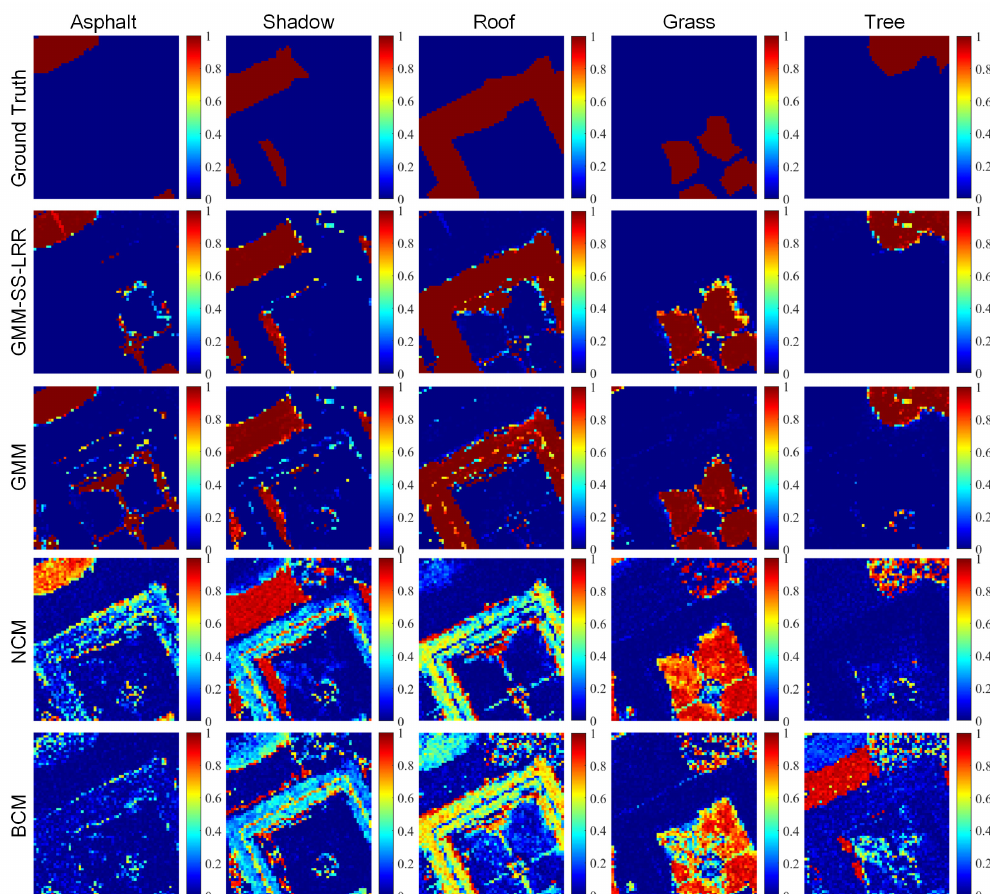
Figure 7. Abundance maps for the Gulfport dataset. From top to bottom: Ground truth, GMM-SS-LRR, GMM, NCM, and BCM. The corresponding endmembers from left to right are: asphalt, shadow, roof, grass and tree.